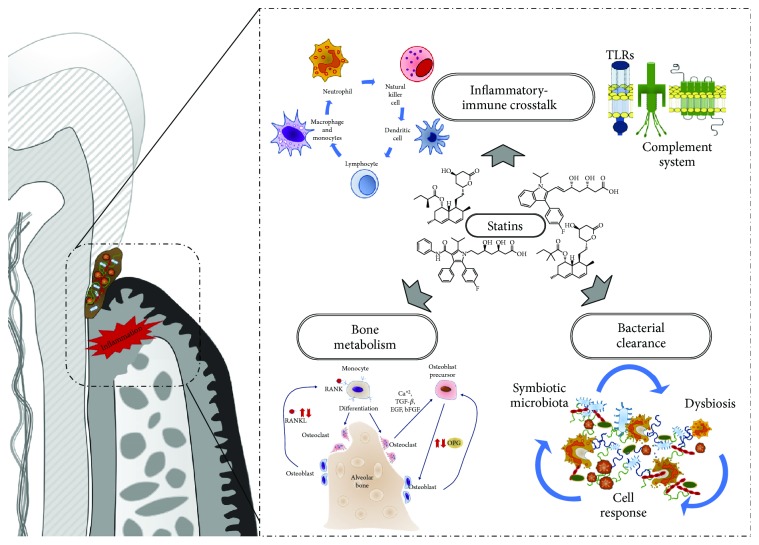
Pleiotropic effects of statins in the context of periodontitis management. Statin biological properties might be of interest for the management of periodontitis as they act on each tissular compartment and mechanisms including inflammatory-immune crosstalk, bone metabolism and bacterial clearance.